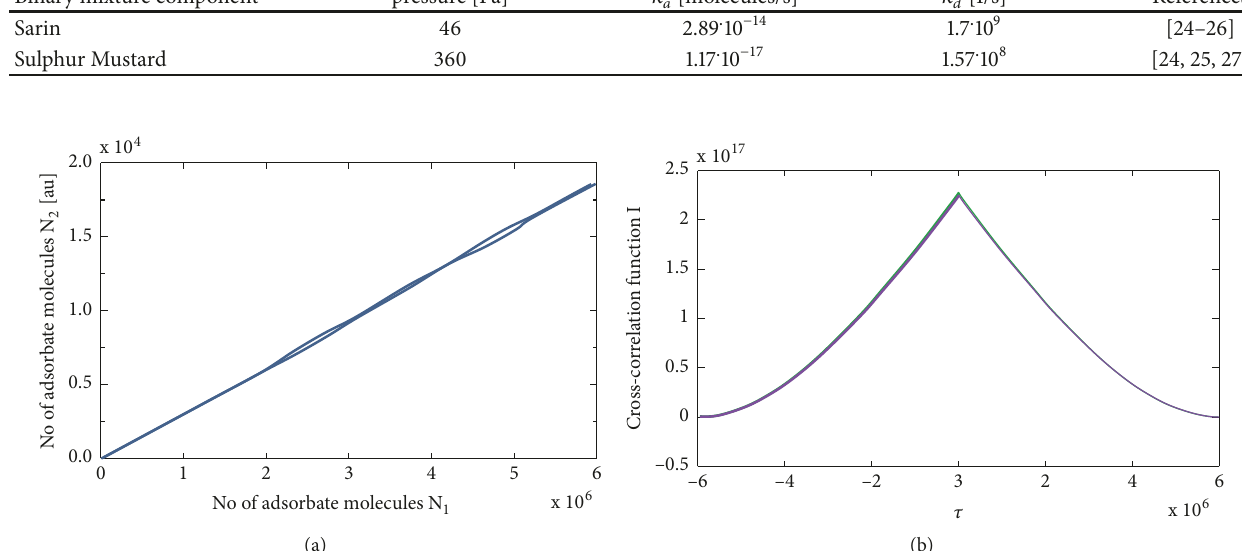
Figure 1: Phase space (a) and the corresponding cross-correlation function (b) of numbers of adsorbed molecules of Sarin and Sulphur Mustard on graphene assuming clean surface in the